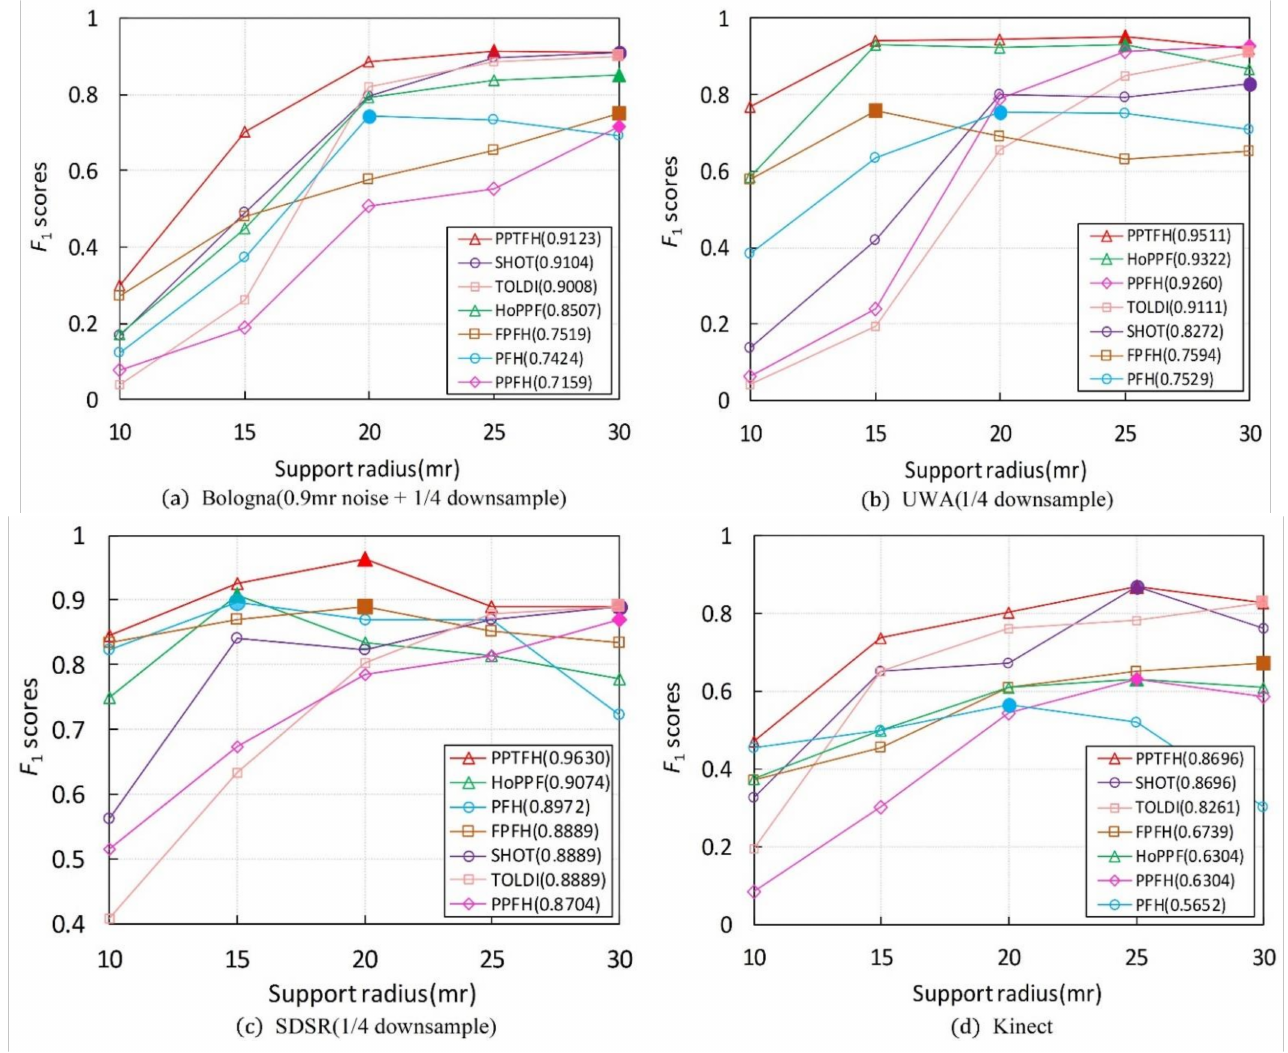
Figure 10. Surface matching performances ( F 1 scores) under different support radiuses for different datasets. The position where the marker for solid color filling locates represents the support radius and F 1 scores when the performance of the descriptor achieves its best, and the value in parentheses represents the highest F 1 scores of each local descriptor. (Figure best seen in